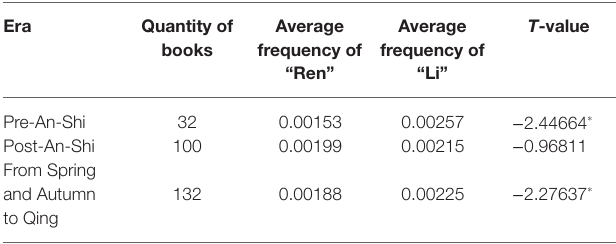
TABLE 3 | T -value between “Ren” and “Li” in different